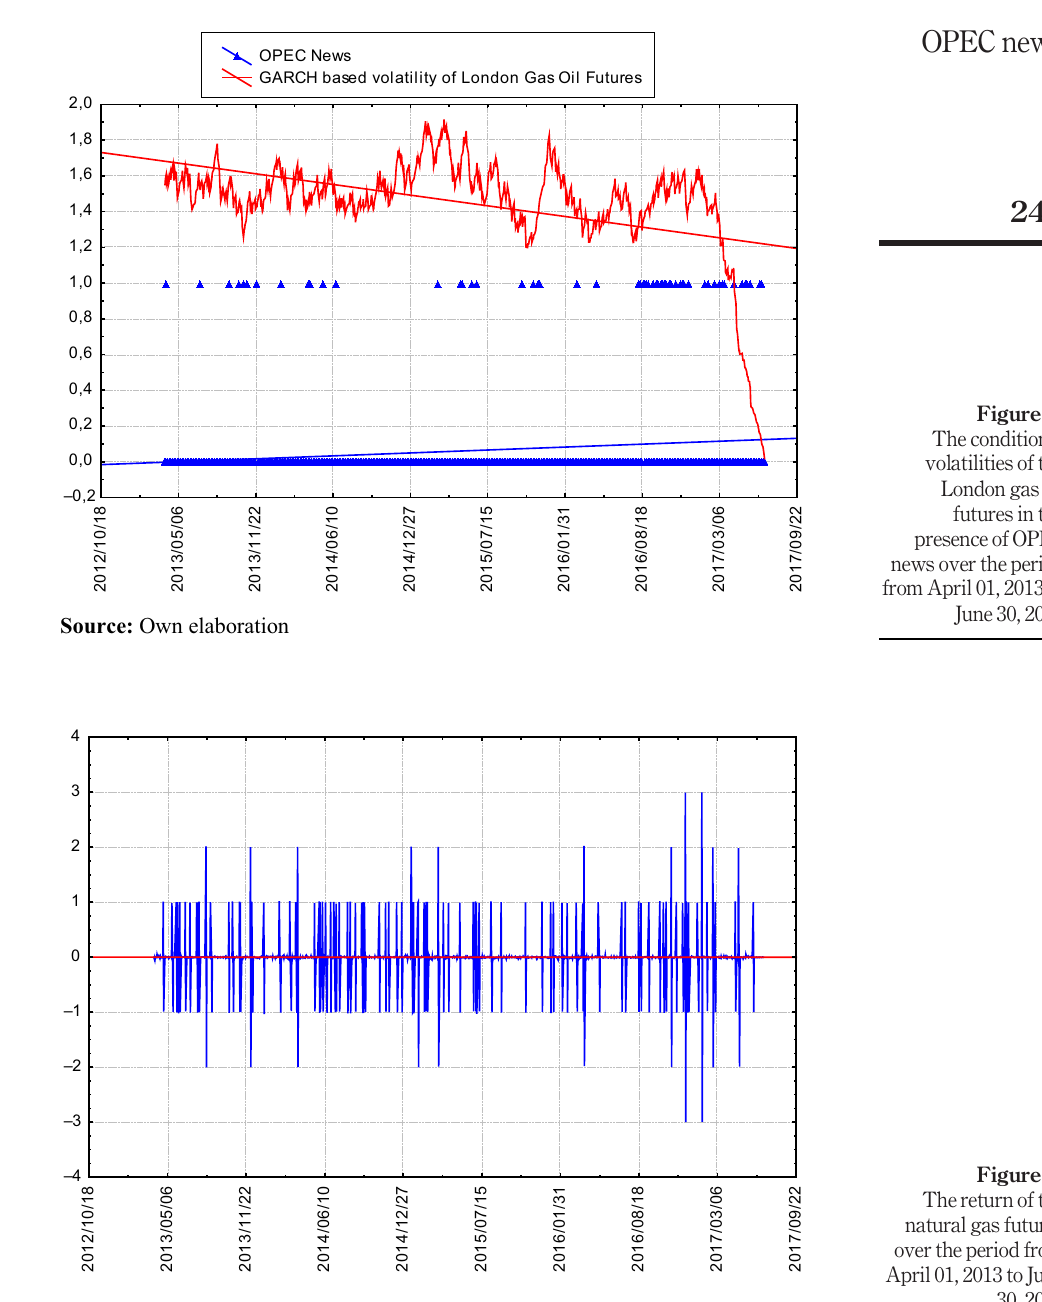
Figure 9. The return of the natural gas futures over the period